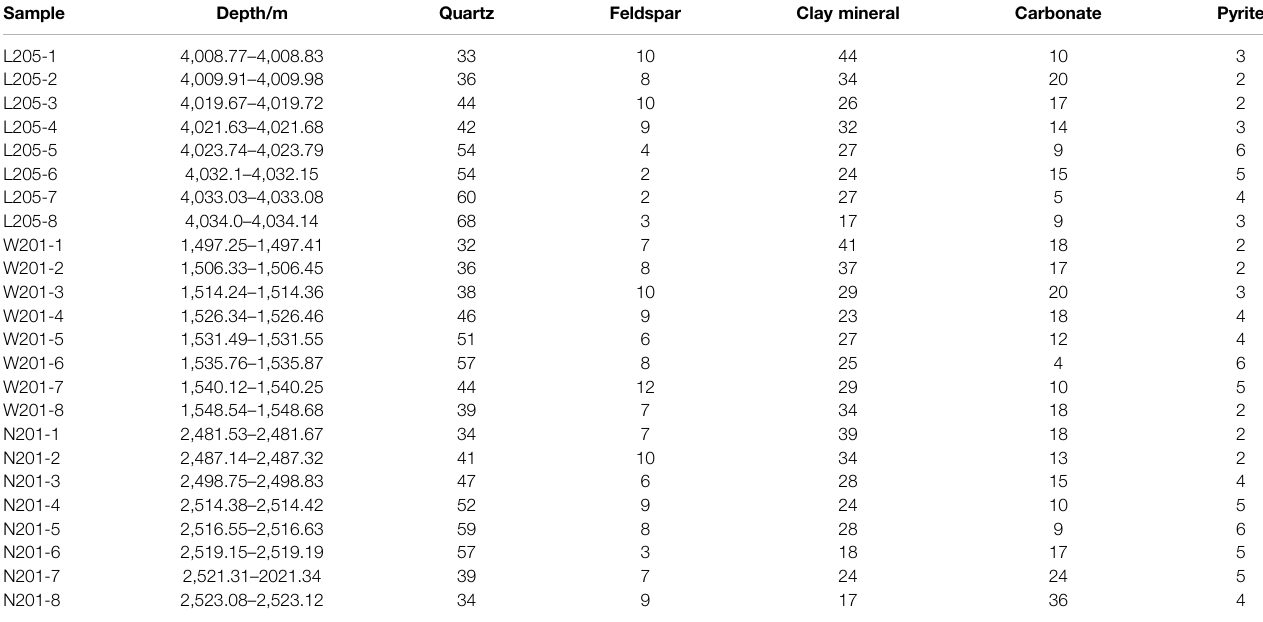
TABLE 4 | Mineral composition of shales in the Wufeng-Longmaxi Formation in southern Sichuan. All experiments were performed at room temperature (26.5 ± 1 °